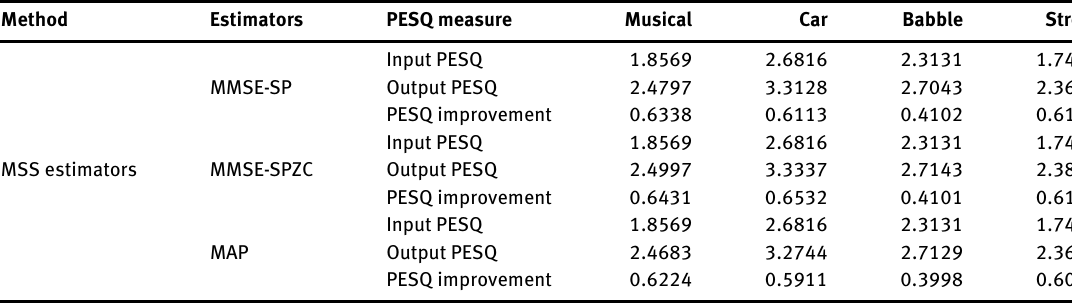
Table 7: Performance Measurement of MSS Estimators in Terms of PESQ for Kannada Database.